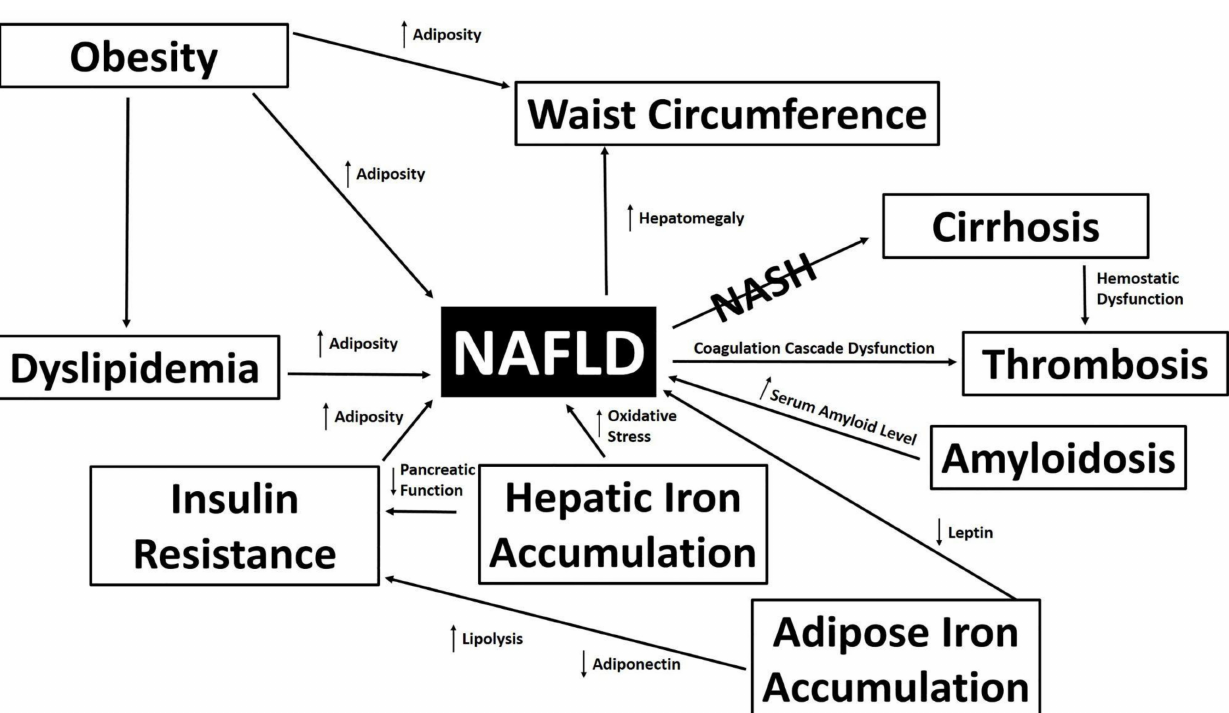
Figure 1. The Pathophysiology of NAFLD. Clinical states and changing metrics associated with NAFLD are